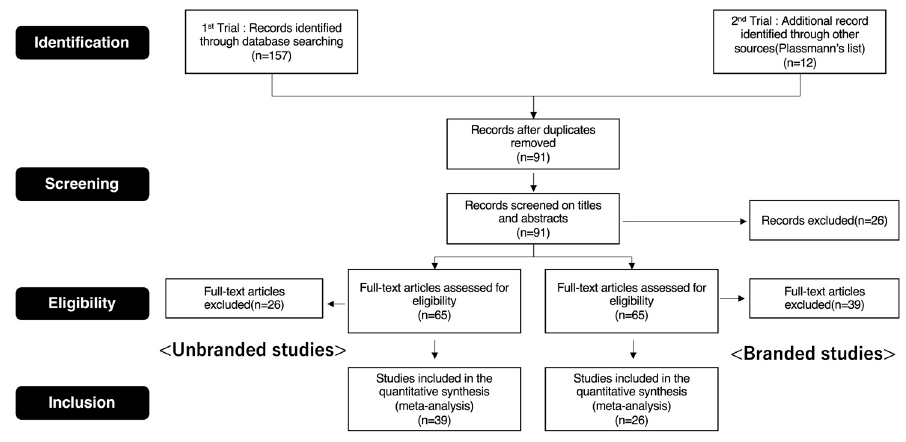
Figure 1. Prisma flow diagram.